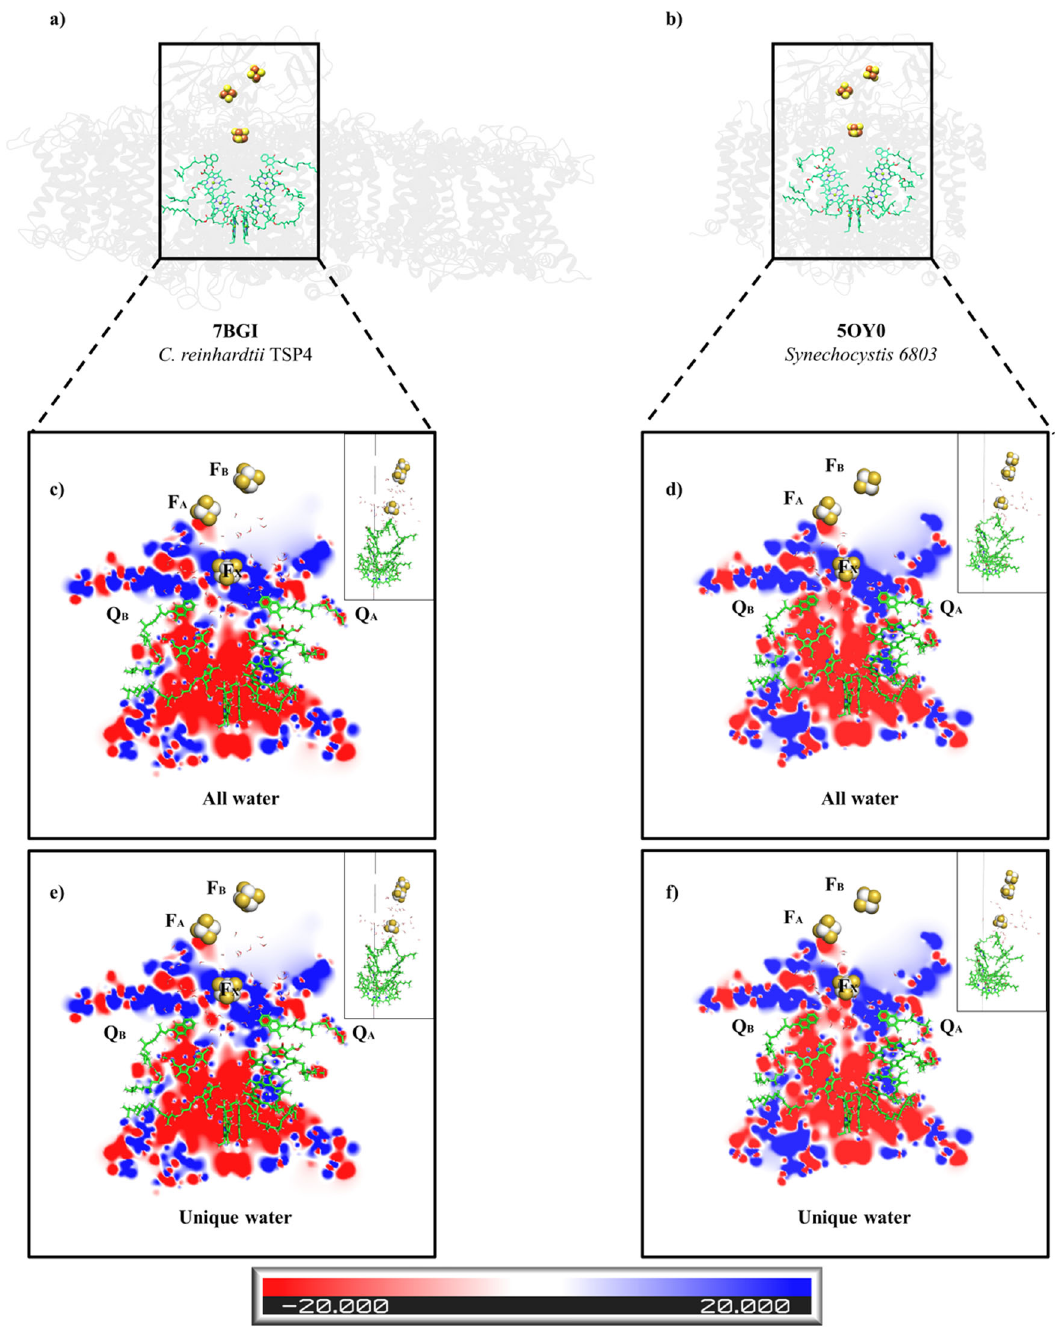
Fig. 4 The electrostatic potentials of the C. reinhardtii TSP4 and Synechocystis PSI RC. The structure of C. reinhardtii TSP4 ( a ) and Synechocystis PSI ( b ) from a membrane plane view. For clarity, only the ligands of the proteins (chlorophylls, quinones and the iron-sulphur clusters) and the water molecules are presented and are marked with a rectangle. The electrostatic potentials were calculated on two conditions: with all of the water molecules found within a 10 Å radius of the FX of C. reinhardtii TSP4 ( c ), or Synechocystis ( d ), or the water molecules that constitute a unique subset to C. reinhardtii TSP4 ( e ), or Synechocystis ( f ). In each case presented hereafter (Supplementary Figs. 11 – 13), the electrostatic potentials are mapped onto three parallel slices, each located at a different position along the RC Y-axis (see the small image on the right side of each fi gure, showing the RC orthogonally, i.e. rotated 90° when compared with the main image). The negative potentials (0 k B T/e > Φ > − 20 k B T/e) are red, the positive potentials (0 k B T/e < Φ < 20 k B T/e) are blue, and the neutral potentials are white (see the colour code at the bottom). Noticeable changes in electrostatic potential appear in the region between the quinones and FX, marked by black